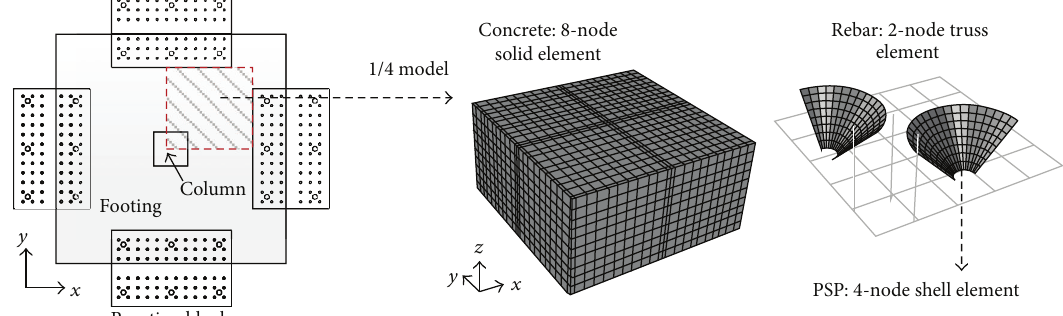
Figure 10: Typical finite element model for the test